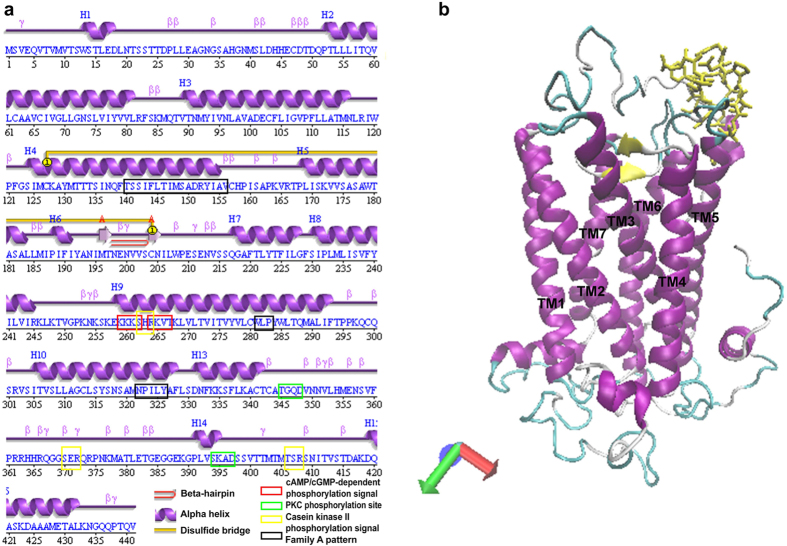
Structural elements of CamAlstR-C.(a) The sequence motifs that were detected in combination of PDBsum and MotifScan. The total protein sequence contains 15 helices (purple ribbons) constituting 7 transmembrane domains and one intracellular C-terminal helix. The receptor has a typical disulfide bridge (yellow connection line) between 127 C and 204 C. There exists a beta hairpin (red U turn) in ECL2 region. The other motifs are shown in rectangular frames. (b) 3D structure predicted in I-TASSER. TM helices are colored purple, beta-hairpin is yellow in new cartoon representation. The ligand is shown in yellow licorice structure. The green-grey loops represent the ICL and ECL regions.